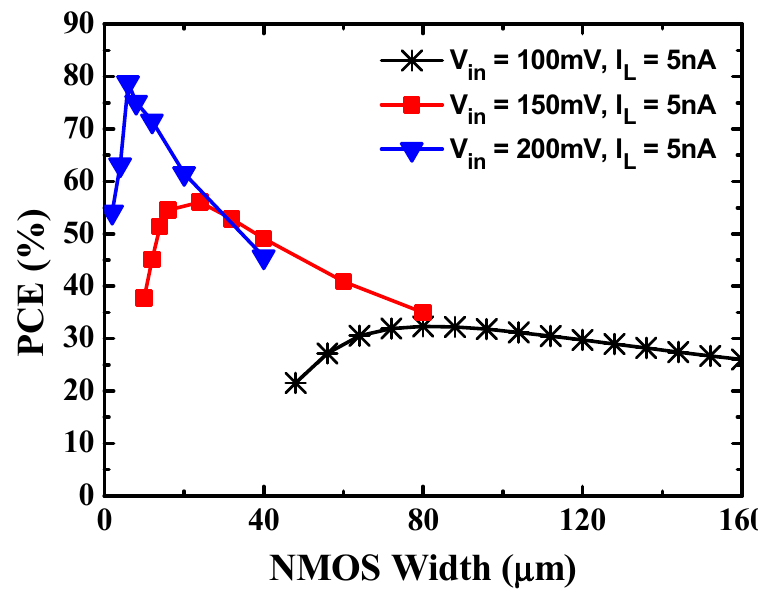
Figure 3. PCE according to NMOS switch width of a one-stage cross-coupled charge pump.